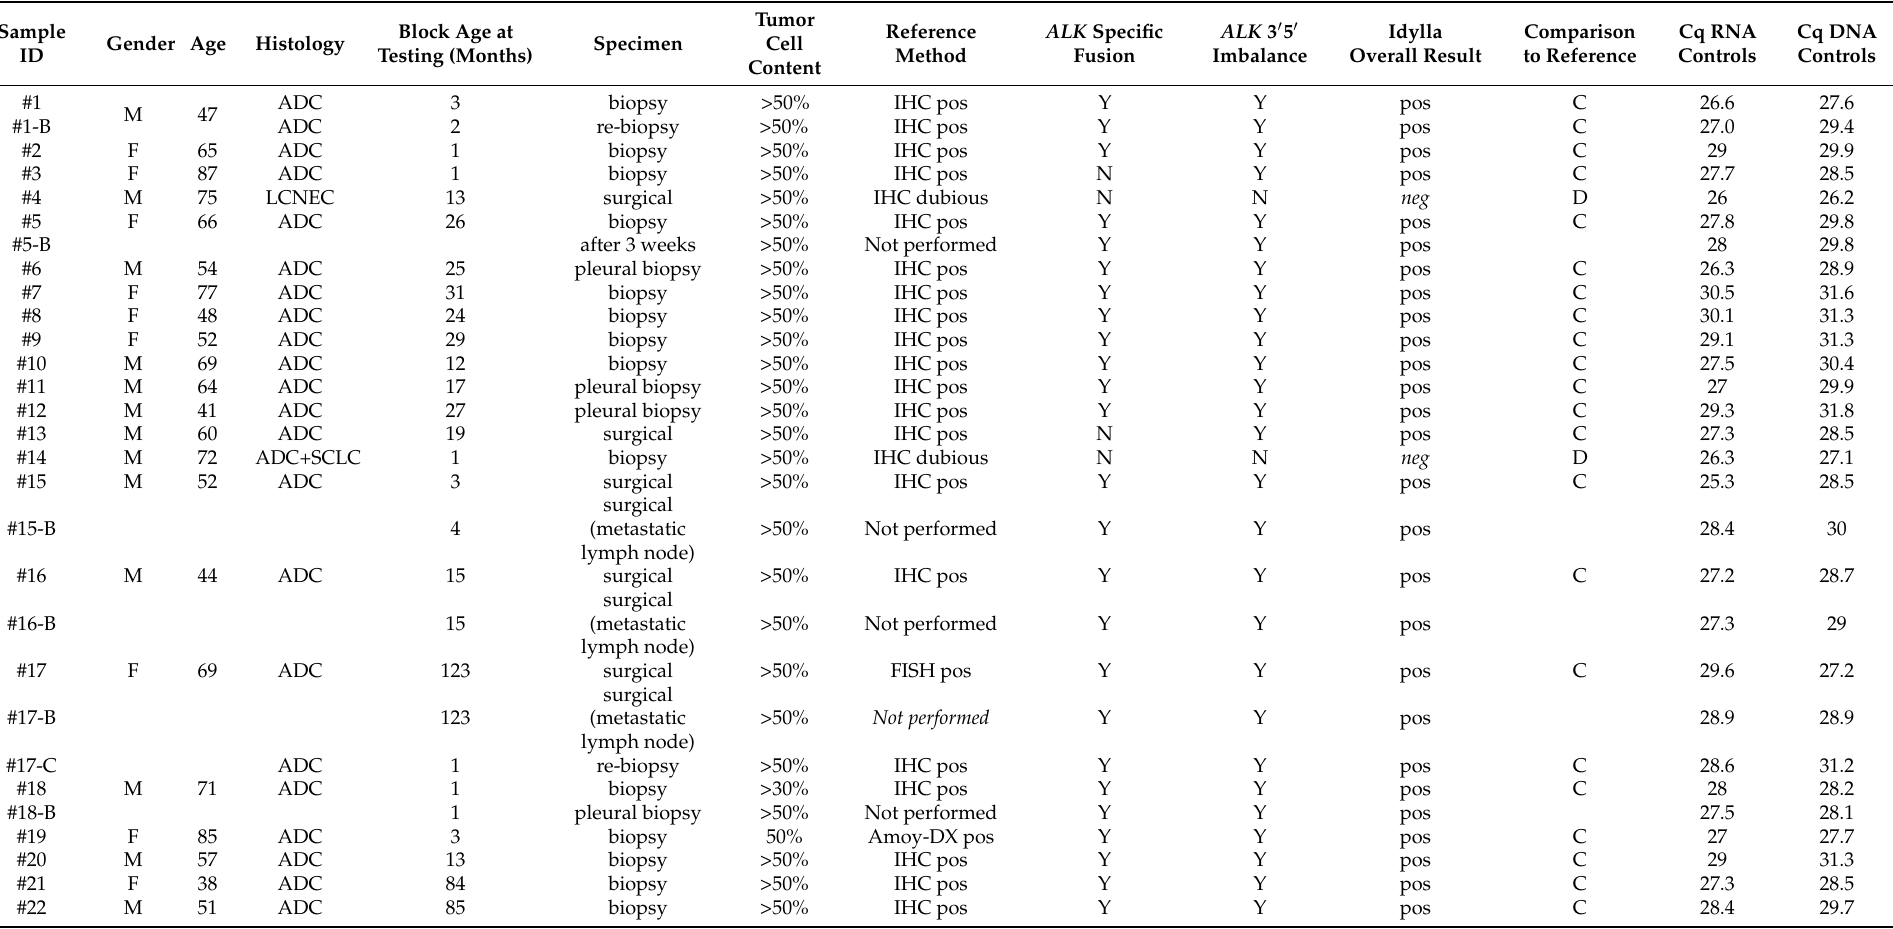
Table 1. Patient characteristics and Idylla TM GeneFusion performance versus reference method for ALK